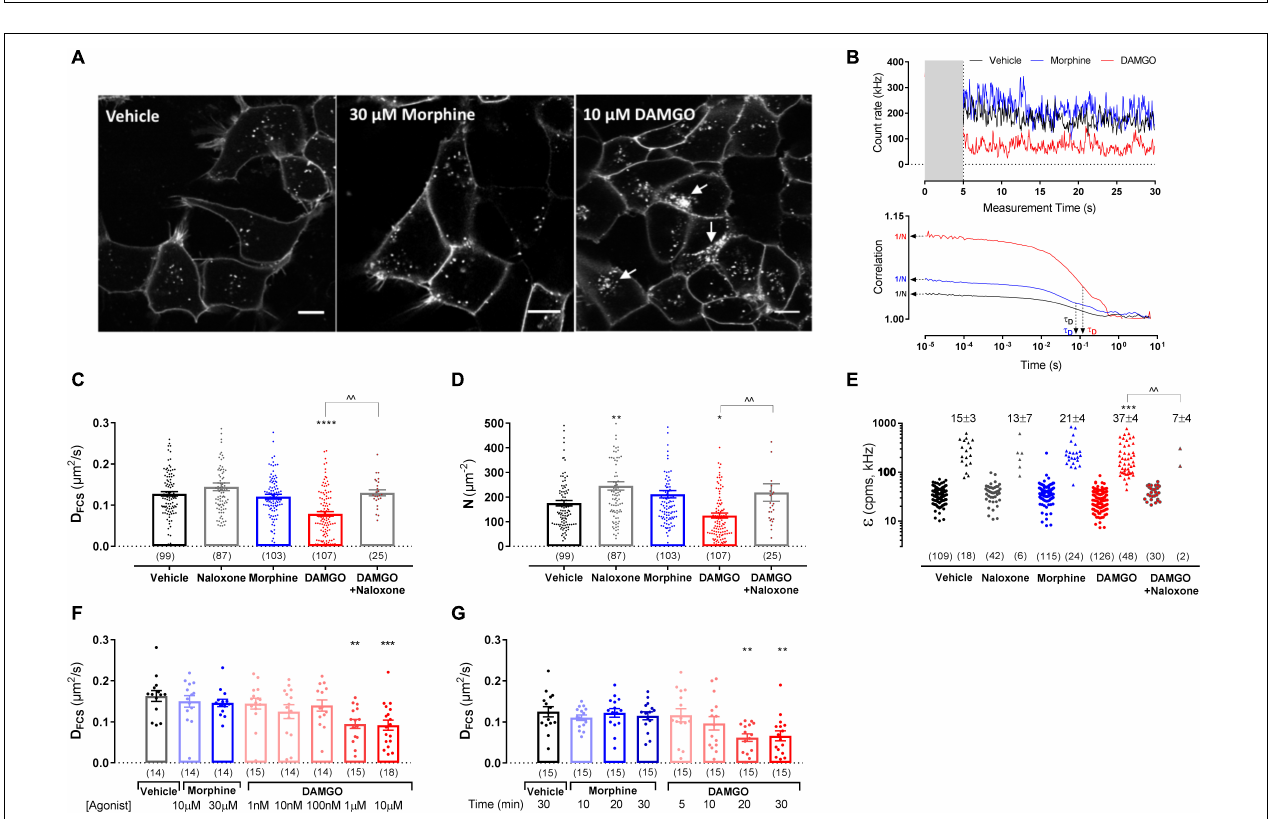
FIGURE 2 | Fluorescence correlation spectroscopy measurements in HEK293 SNAP-MOP cells following ligand stimulation. (A) Representative images from HEK293 SNAP-MOP cells labeled with SNAP-Surface 488 (BG-488) dye after stimulation with vehicle, 30 µ M morphine or 10 µ M DAMGO for 20 min. Scale bar 10 µ m; arrows represent agonist-induced internalization. (B) Representative FCS traces from single HEK293 SNAP-MOP cells after stimulation with vehicle, 30 µ M morphine, or 10 µ M DAMGO for 20 min (gray area indicates the initial 5 s of data that were removed, see section “Materials and Methods”), and their corresponding AC fit indicating N and τ D of SNAP-MOP. (C) Diffusion coefficient of SNAP-MOP upon stimulation with 30 µ M naloxone, 30 µ M morphine, 10 µ M DAMGO (20 min, 37 ◦ C), or 10 µ M DAMGO after pre-treatment with 30 µ M naloxone (30 min, 37 ◦ C) ( n = 25–107 cells from 5 to 23 independent experiments; one-way ANOVA, F (df1,df2): F (4,416) = 15.04, P < 0.0001). (D) Particle number of SNAP-MOP upon stimulation with 30 µ M naloxone, 30 µ M morphine, 10 µ M DAMGO (20 min, 37 ◦ C), or 10 µ M DAMGO after pre-treatment with 30 µ M naloxone (30 min, 37 ◦ C) ( n = 25–107 cells from a minimum of 5 independent experiments; F (4,416) = 11.06, P < 0.0001). (E) Molecular brightness of SNAP-MOP after stimulation with 30 µ M naloxone, 30 µ M morphine, 10 µ M DAMGO, or 10 µ M DAMGO after pre-treatment with 30 µ M naloxone. For each condition, brightness values for the first (left) and second (right) component are shown [ n = 30–126 cells from